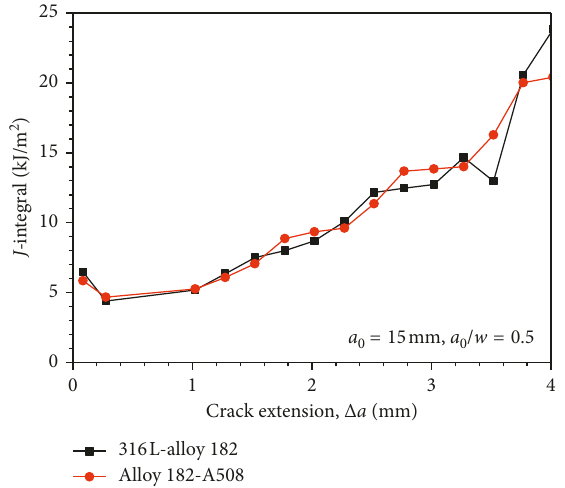
Figure 15: J - Δ a curves at different interfaces of DMW